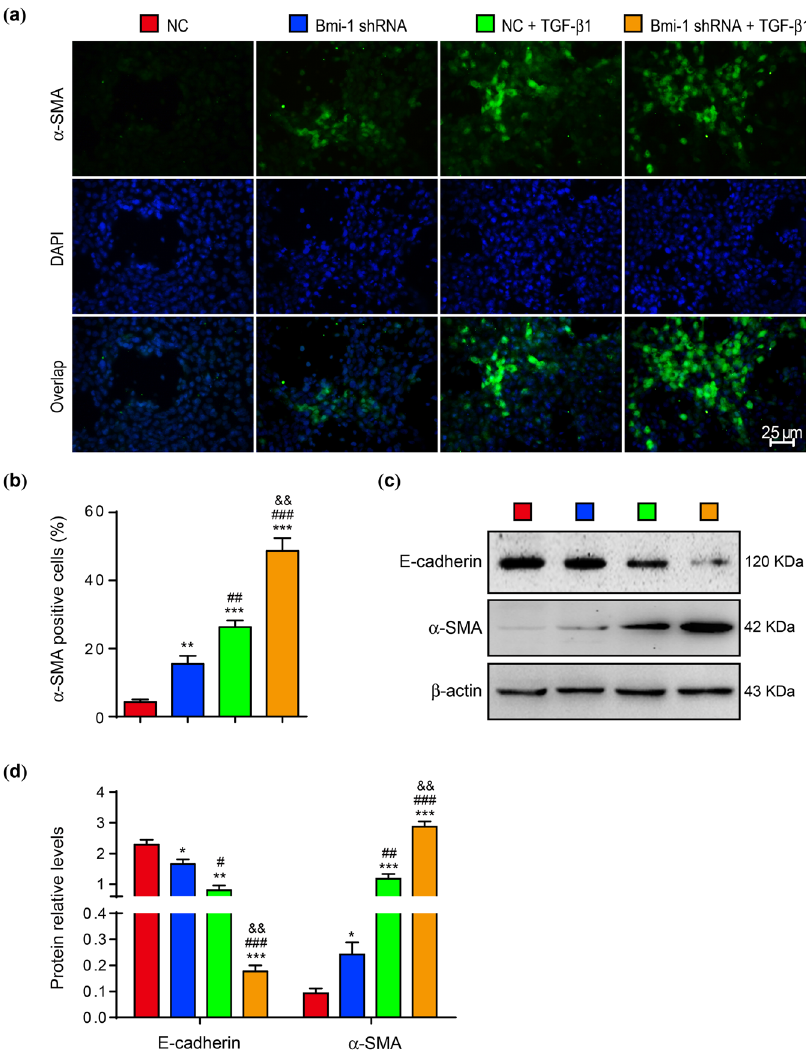
Figure 7. Exogenous TGF- β 1 further induced the EMT of Bmi - 1 -knockdown HK2 cells. ( a ) Representative micrographs of HK2 cells from negative control (NC), Bmi - 1 -knockdown (Bmi-1 shRNA), NC treated with TGF- β 1 (NC + TGF- β 1), and Bmi - 1 -knockdown treated with TGF- β 1 (Bmi-1 shRNA + TGF- β 1) groups stained by immunofluoresence for α -SMA (green, 1 st line) with DAPI for nuclei (blue, 2 nd line); overlap (3 rd line). ( b ) Percentage of α -SMA-positive cells relative to total cells. ( c ) Western blots of these HK2 cell extracts showing E-cadherin and α -SMA. β -actin was the loading control. ( d ) α -SMA protein relative to β -actin, assessed by densitometric analysis. Six biological replicates were used for these studies per experiment. Values are mean ± SEM of six determinations per group. * P < 0.05; ** P < 0.01; *** P < 0.001 compared with NC group. # P < 0.05; ## P < 0.01; ### P < 0.001 compared with Bmi-1 shRNA group; && P < 0.01 compared with NC + TGF- β 1